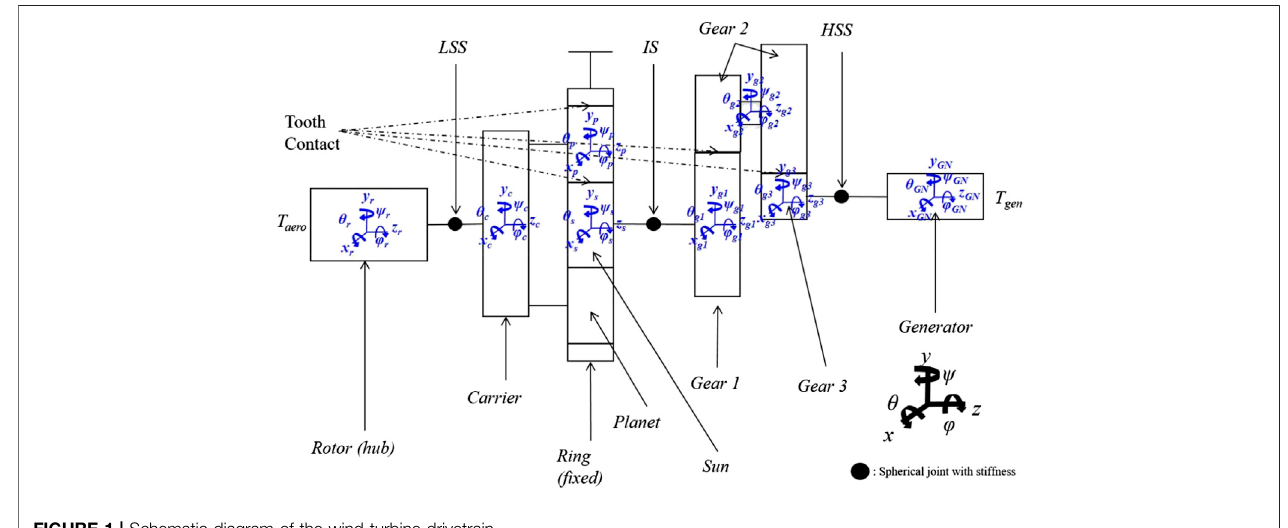
FIGURE 1 | Schematic diagram of the wind turbine drivetrain.